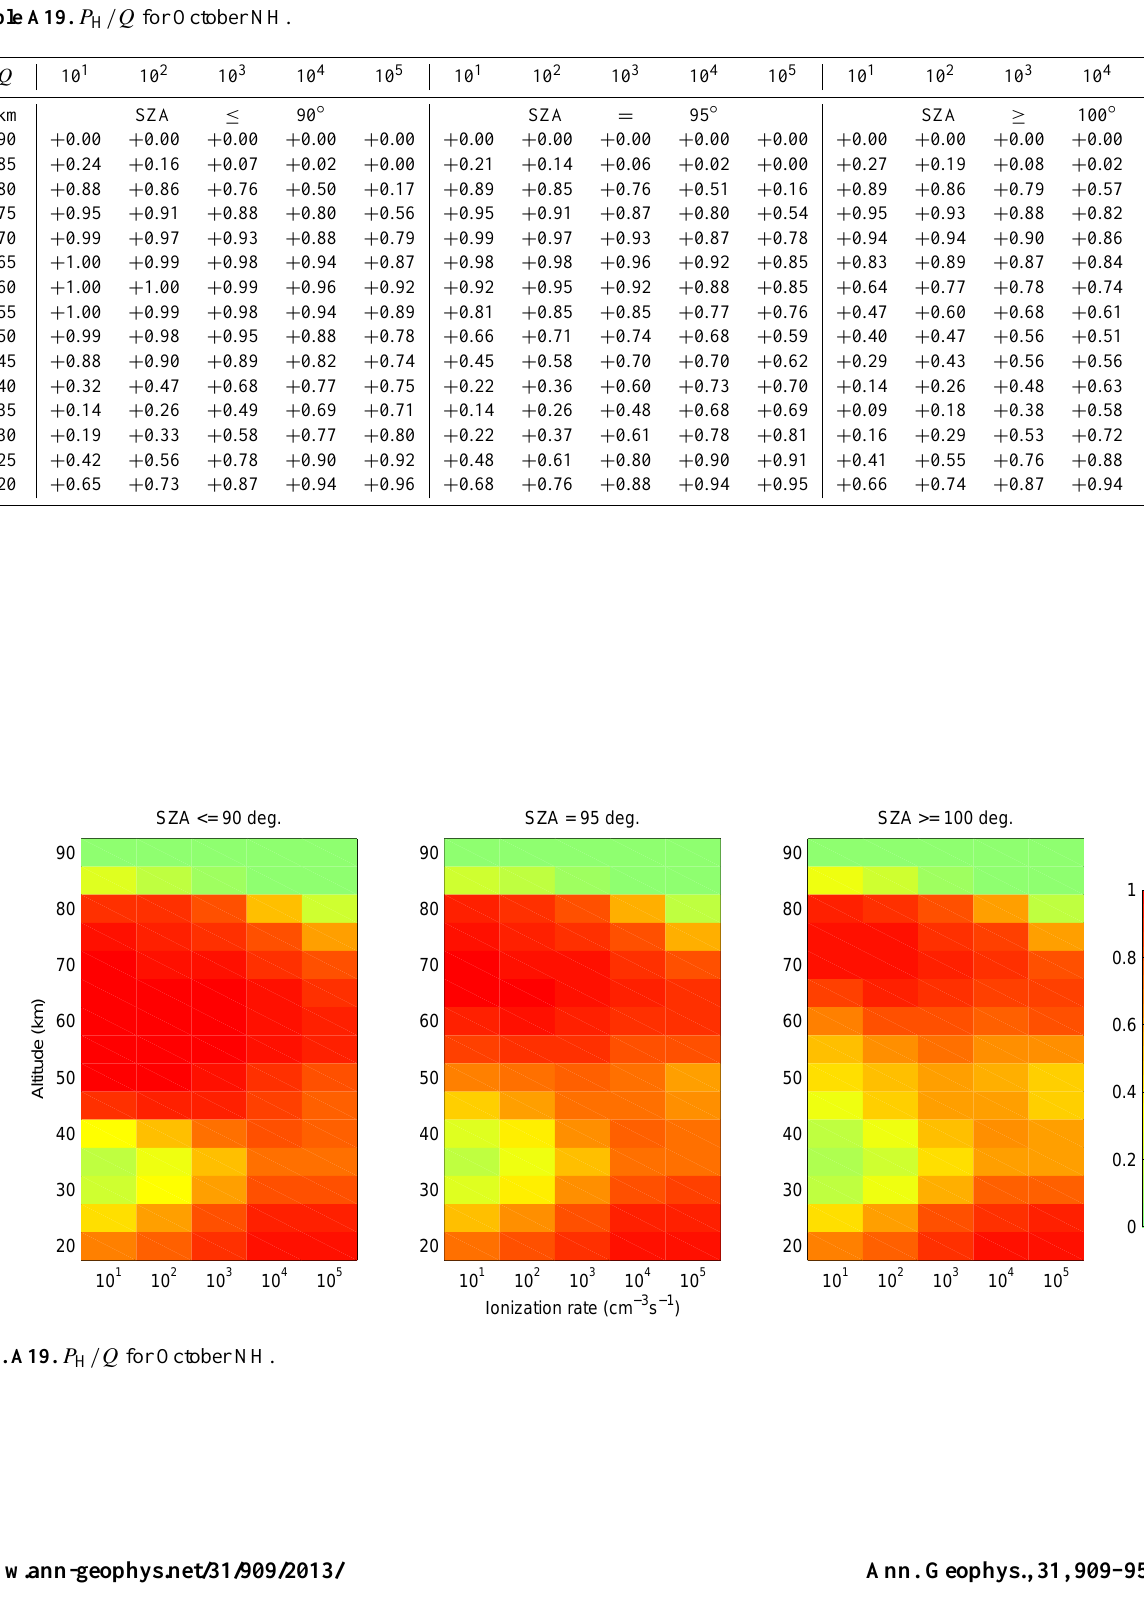
Table A19. P H /Q for October NH.